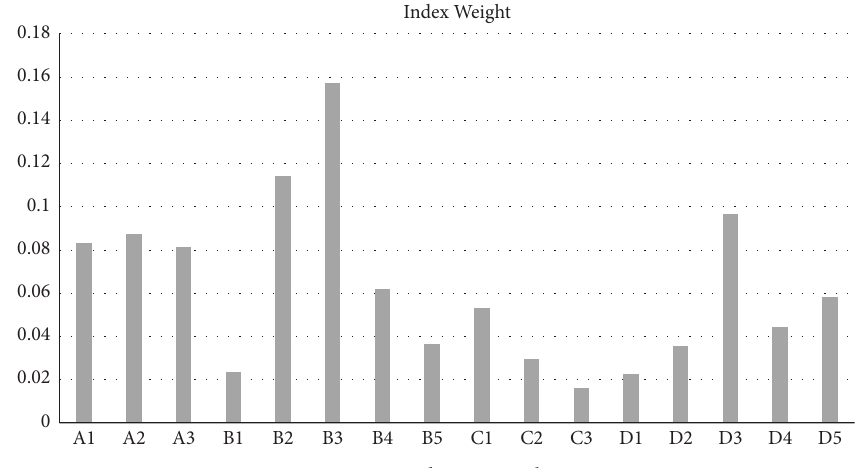
Figure 1: Indicator